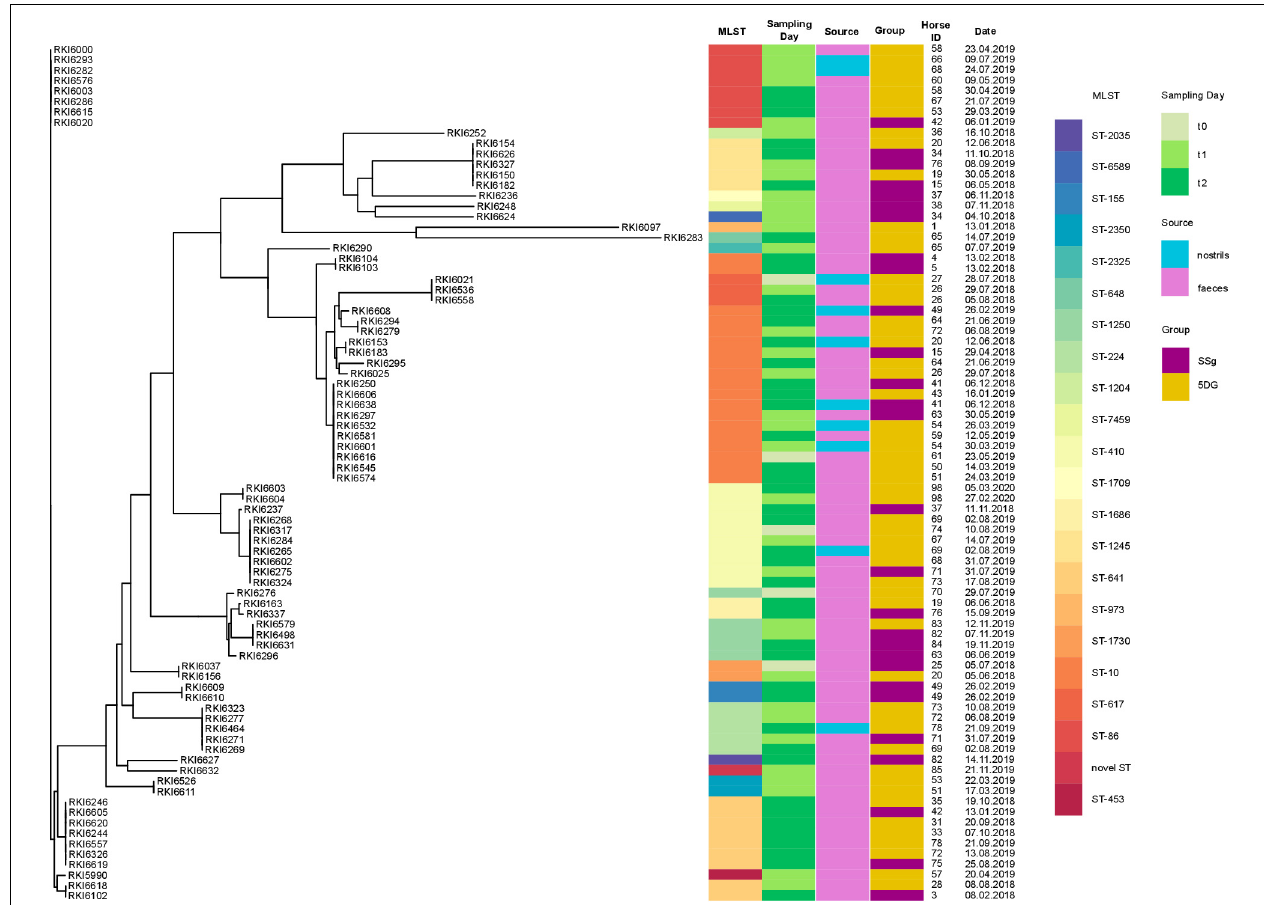
FIGURE 3 | Core-genome based phylogeny of 82 equine ESBL-EC isolated from hospitalized horses subjected to colic surgery. Maximum likelihood phylogenetic tree generated with RAxML and visualized using the CLC Genomics Workbench based on 2,700 orthologous genes from 82 ESBL-EC WGS. Sequence type (MLST), sampling day (t 0 , t 1 , or t 2 ), individual horses (ID), sampling date, sampling site (source) and study group (SSG or 5DG) are